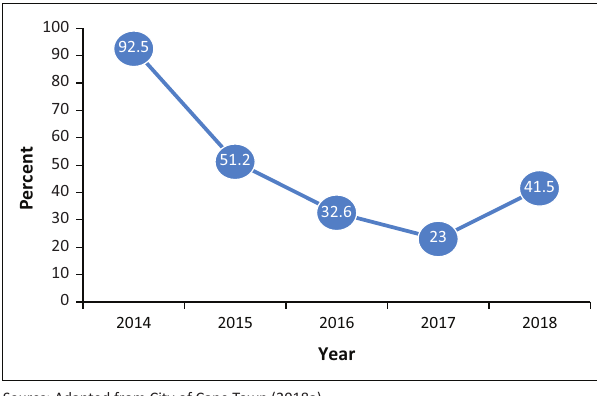
Source : Adapted from City of Cape Town (2018a) FIGURE 2: Trends in dam water levels for six largest dams supplying Cape Town (2014–June 2018).